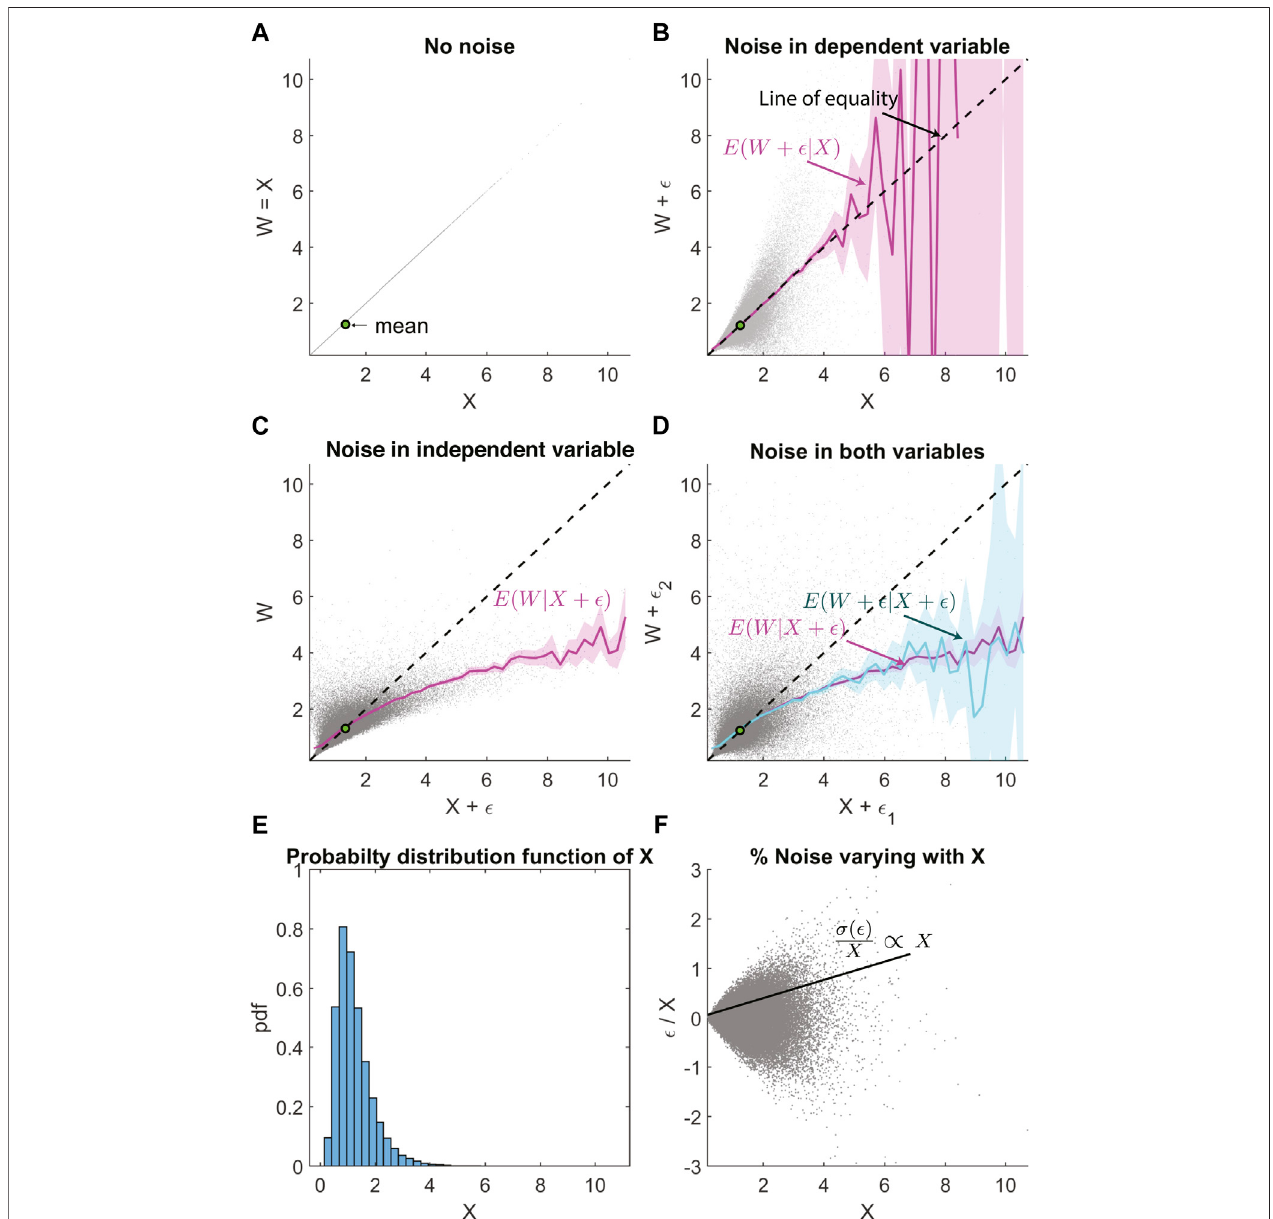
FIGURE4| Similarlayoutas Figure1 ,butwithlog-normaldistributionandcorrelatednoisesuchthat σ ( ϵ ) ∝ X 2 . (A) ScatterplotofWvs.X,whereXisalog-normally distributedrandomvariableandW=X. (B) CorrelatedGaussiannoise ϵ isaddedto W .Magentalineshowstheconditionalexpectation E ( W + ϵ | X ).Thedashedblackline isthelineofequality. (C) CorrelatedGaussiannoiseaddedonlyto X ,withthemagentaline E ( W | X + ϵ )showingregressionbias. (D) CorrelatedGaussiannoiseisaddedto both W and X , with regression bias in E ( W + ϵ | X + ϵ ) is visible in the cyan line. This overlaps with the magenta line that shows E ( W | X + ϵ ) for comparison. (E) Probability distribution function X showing the log-normal distribution. (F) The fractional error is proportional to X .